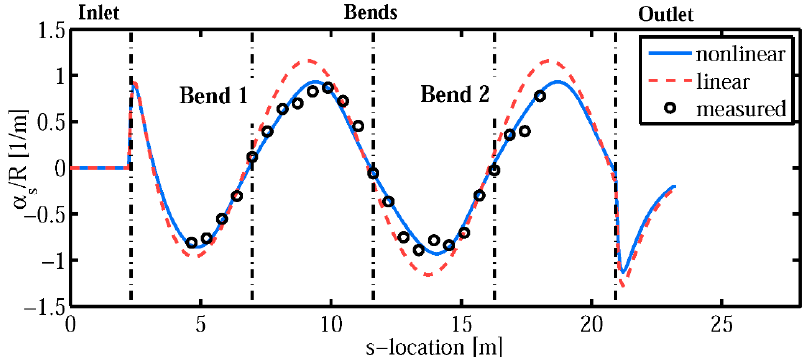
Figure 3. The α s /R profiles computed from the nonlinear model (solid line), the linear model (dash line) and the measured data (circles) for the S110 case. The dash ‐ dotted lines indicate the locations of meander apexes.